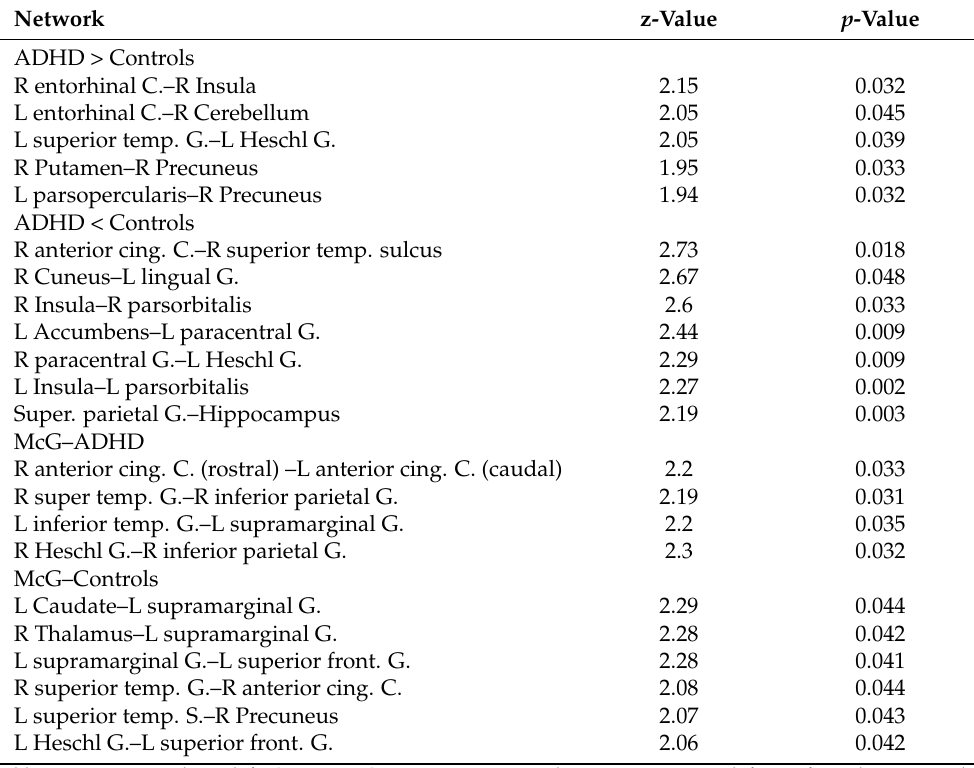
Table 1. Network statistics for ADHD vs. controls and brain–behavior relationship. Network